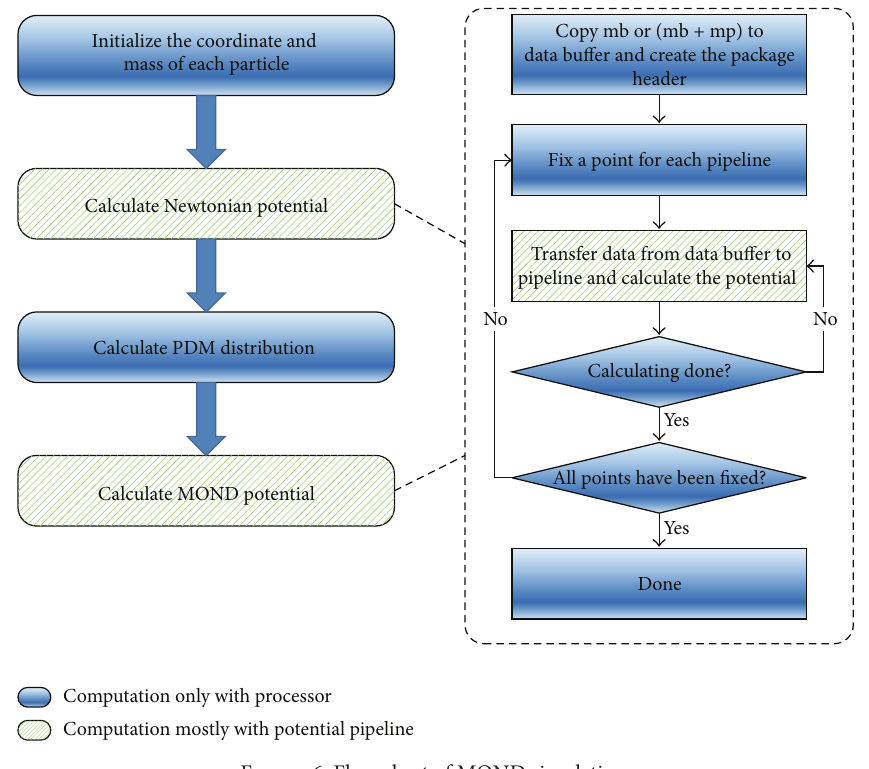
Figure 6: Flow chart of MOND simulation.